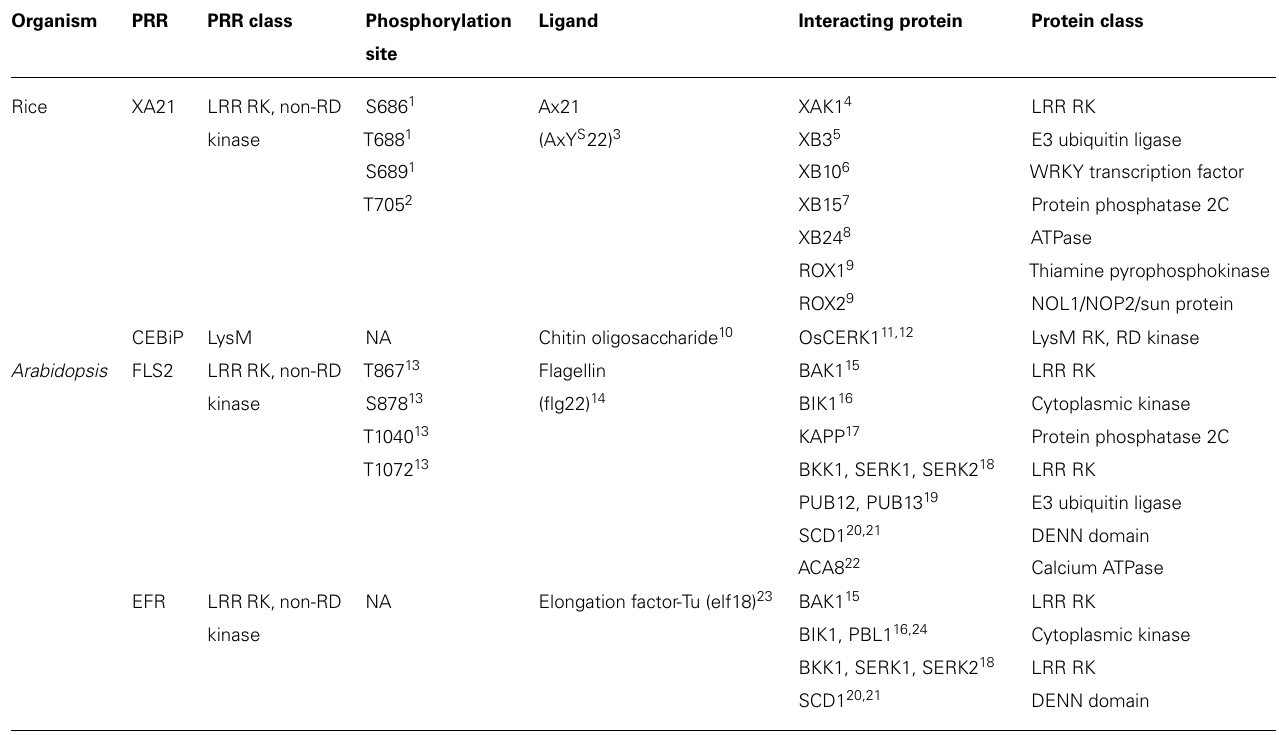
Table 1 | Summary of rice and Arabidopsis